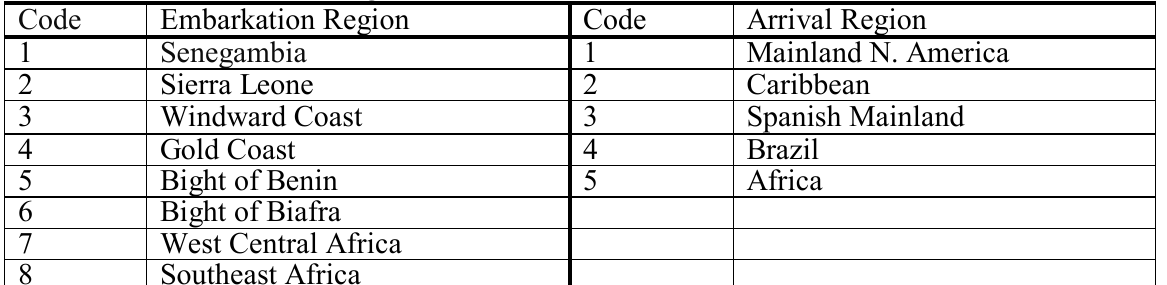
Table 1. Regions of embarkation and arrival for Atlantic slave